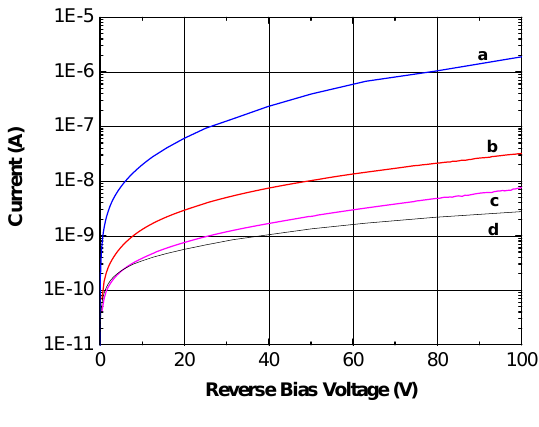
Figure 9. Comparison between standard and new structures leakage currents: (a) Pt/CdTe/Pt commercial device; (b) i-n detector before H O treatment and d) In/CdTe/Pt commercial after H 2 2